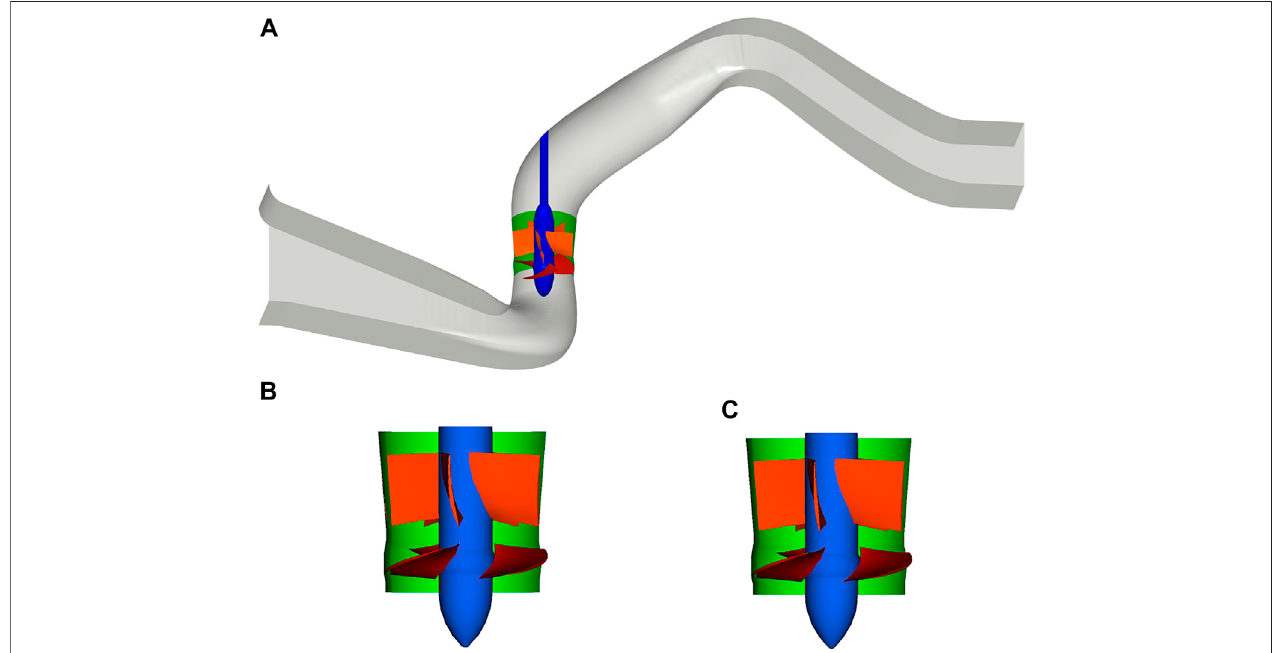
FIGURE 8 | Perspective view of the model vertical axial fl ow pump device. (A) Pump Device, (B) Pump Segment ( Δ β = 0 ° ), (C) Pump Segment ( Δ β = − 12 ° )